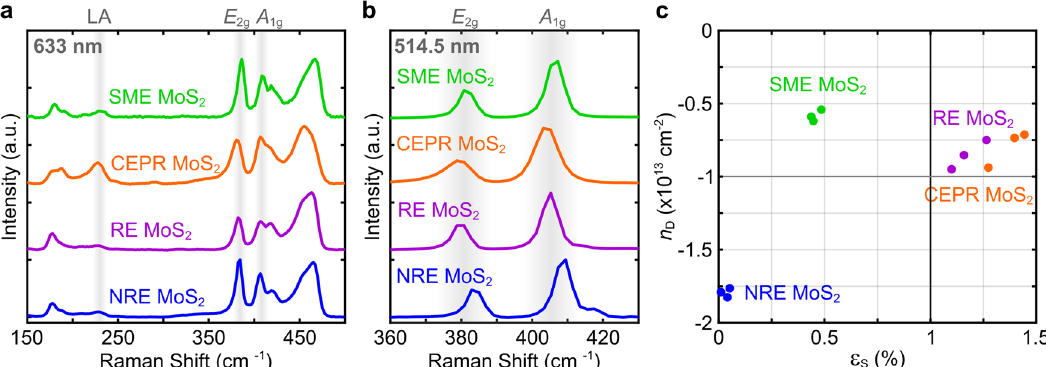
Fig. 6 Vibrational modes, carrier doping, and intra fl ake lattice strain of the exfoliation procedure-dependent MoS 2 . a Resonant and b non-resonant Raman spectra for each fi lm of exfoliated MoS 2 . c Plot of the amount of intra fl ake doping and strain present in each fi lm representing exfoliated MoS 2 fl akes. The values shown in c were calculated with the peak frequencies shown in b using Eqs. 1 and 2. Three measurements were taken for the responses shown in c to illustrate the potential spread in doping and strain within the same MoS 2 fi